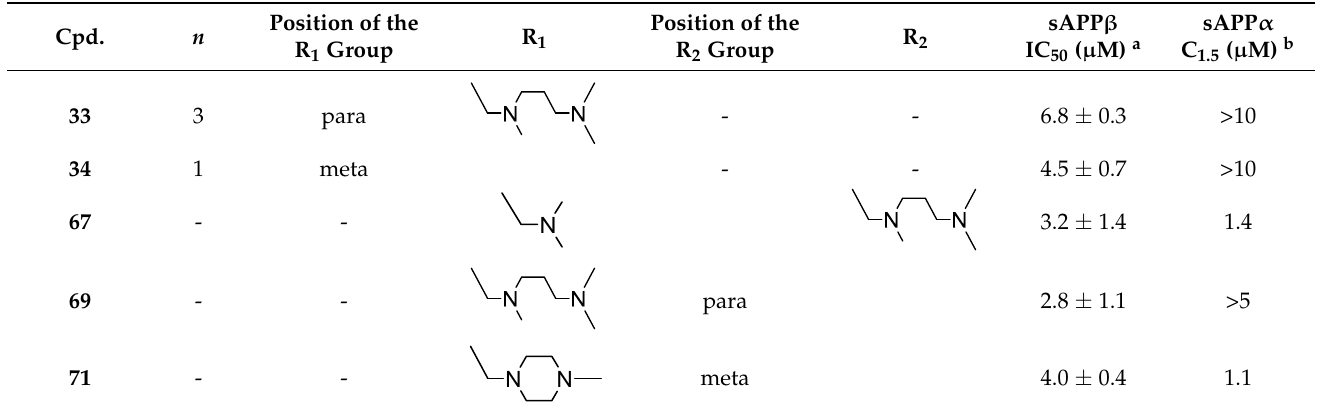
a Compound concentration inhibiting 50% of sAPP β secretion in SY5Y cells. IC mean ± SD of at least three experiments performed in triplicate. b C 1.5 indicates the concentration of compound necessary to increase by 1.5-fold the amount of sAPP α fragments compared to the untreated control